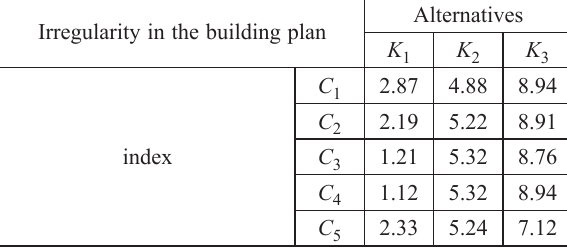
Table 19. Averages of experts’ scores for alternatives of the irregularities in the building plan within the major index Irregularity in the building